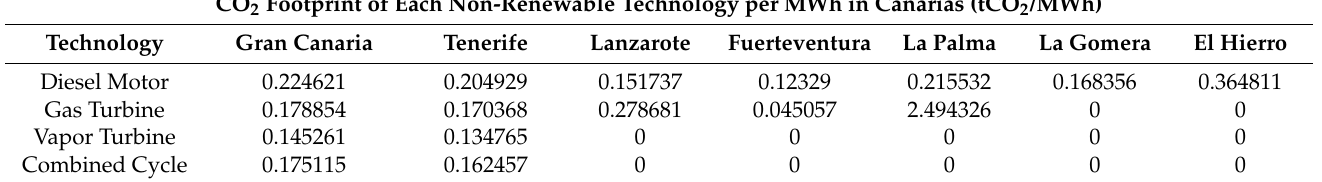
Table 10. CO 2 footprint of each non-renewable technology per MWh in the Canary Islands (tCO 2 /MWh) (2017) [16].